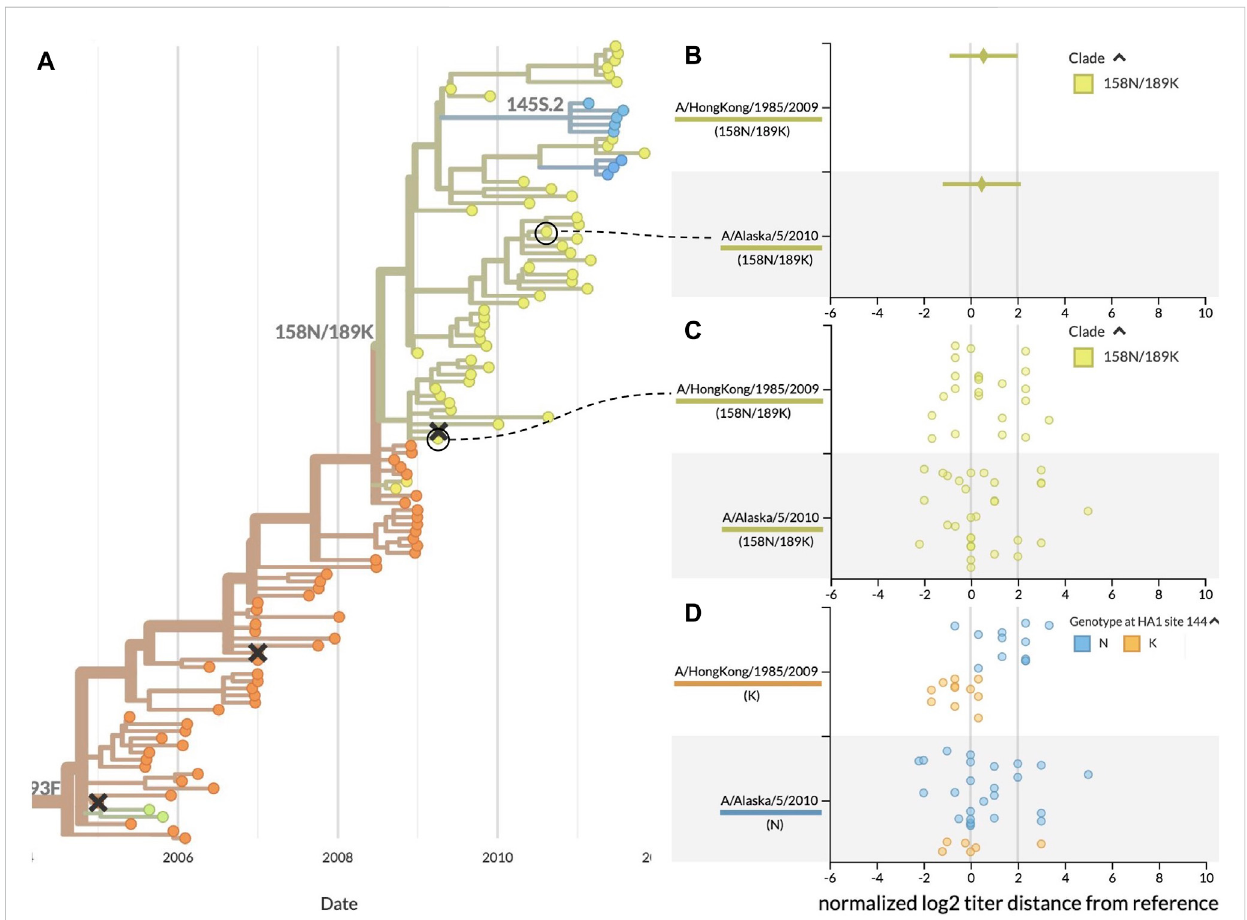
FIGURE 4 Antigenic distances from HI assays between clade 158N/189K reference and test viruses, highlighting two reference viruses with similar mean distances and raw distributions. (A) Summary phylogenetic tree with clade 158N/189K shown in yellowish green. (B) HI measurements when viewed as mean ± standard deviation show similar average values for two reference viruses and a wide range of antigenic diversity per reference. (C) Viewing the individual measurements reveals a previously hidden bimodal distribution in the measurements for both reference viruses. (D) Coloring individual measurements by genotypes at the putative antigenic site HA1:144 shows a potential genotype-speci fi c explanation for the two clusters seen in the A/ HongKong/1985/2009measurements. Incontrast, measurementsfor A/Alaska/5/2010haveahighvariancethatcannot beexplained bythegenotypeof test viruses at HA1:144. This genotype-speci fi c coloring reveals patterns that were not clear when coloring by clade